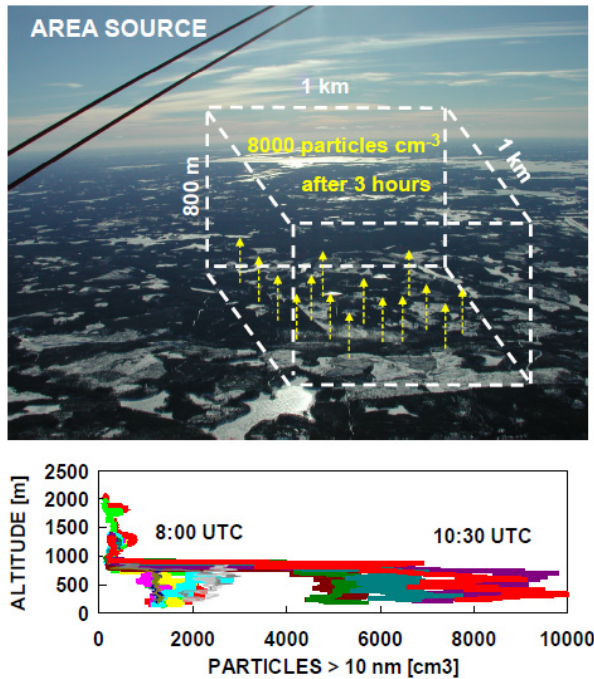
Fig.4: Particle production over the boreal forest of Finland. 20 consecutive vertical profiles were flown over and in the vicinity of the ground based station of Hyytiälä between the free troposphere and about 5 m above ground to follow the development of the particle number concentrations and the growth of the mixed layer in the morning. Panel b shows the individual profiles, marked by different colors, of particles in the D > 10 nm range, final D > 3 nm particles up to 35000 cm -3 (not shown). Brown, yellow and violet profiles below 2000 particles / cm 3 were flown before the onset of nucleation, brown and green with ~ 5000 cm -3 during the event over the lakes, profiles with more than 8000 cm -3 over the forest towards the end of the event.